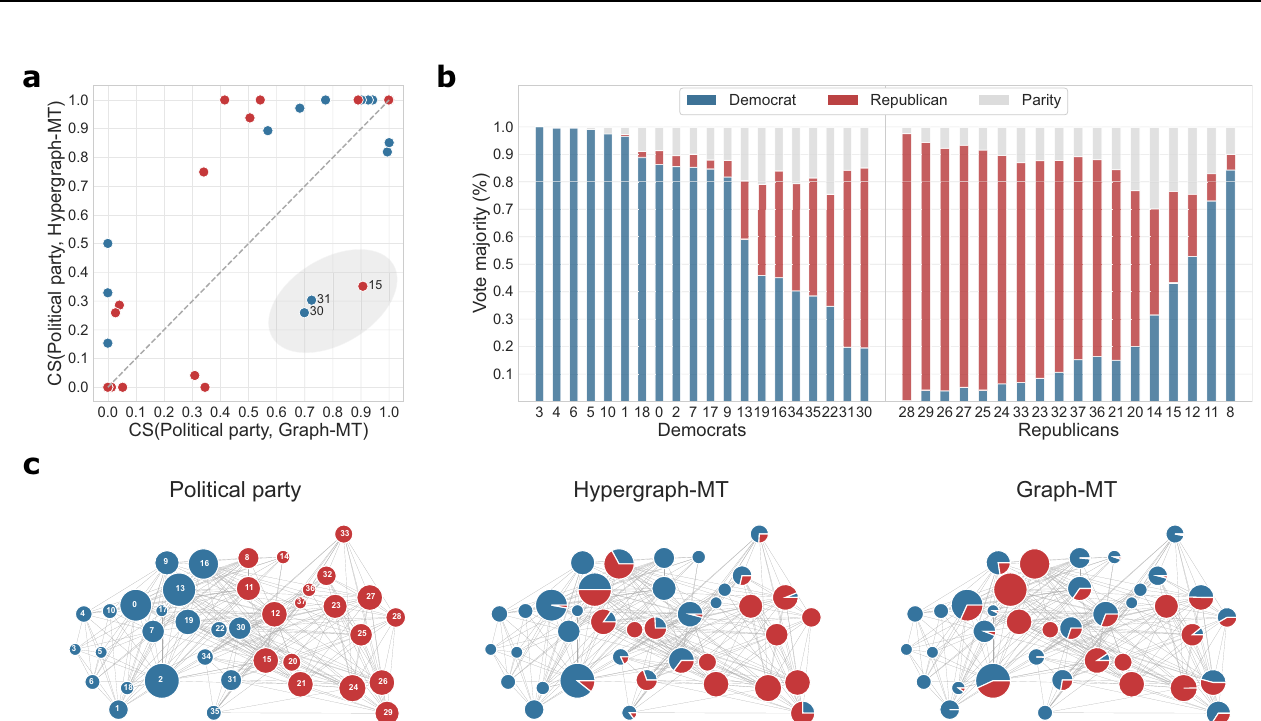
Fig. 2 | Critical size for hyperedge prediction in a Gene-Disease dataset. We measure the AUC by varying the maximum hyperedge size D . The results are averages and standard deviations over 5-fold cross-validation test sets, and the baseline for AUC is the random value 0.5. We run the model on the hypergraphs (Hypergraph-MT), the graphs obtained by clique expansions (Graph-MT), and the graphs given only by the registered pairwise interactions (Pairs-MT). To perform a